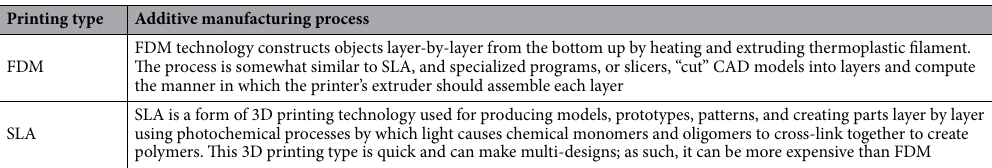
Table 1. Descriptions of two types of 3D printing techniques, including FDM and SLA. 3D three-dimensional, CAD computer-aided design, FDM fused deposition modeling, SLA